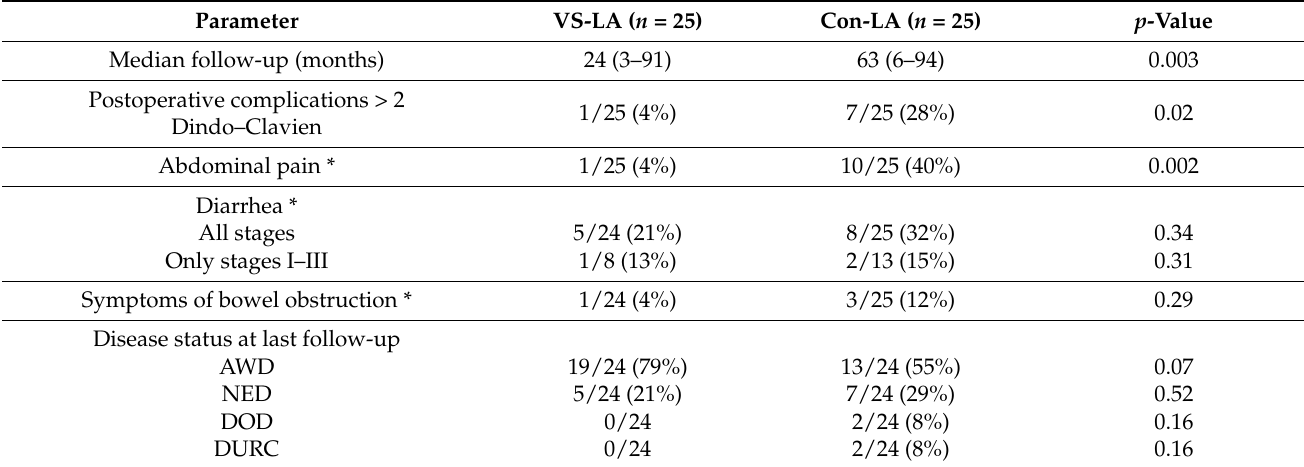
Table 3. Postoperative course and